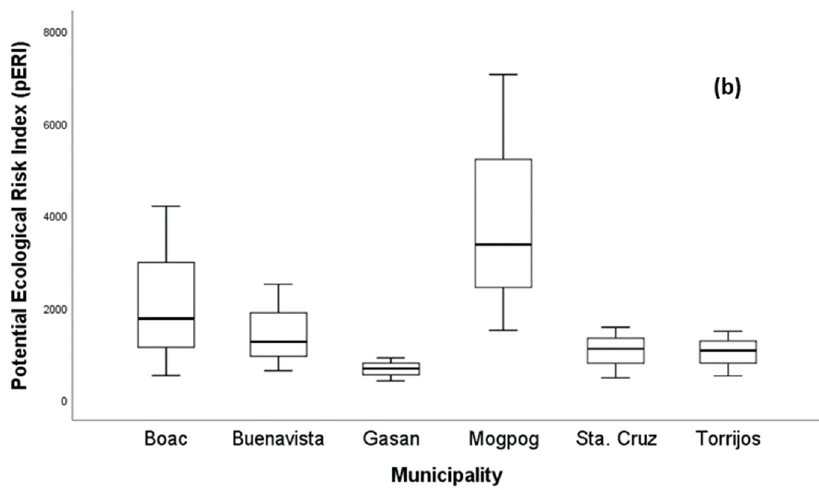
Figure 3. Boxplot of ( a ) the Nemerow synthetical pollution index and ( b ) risk index of metal in soil.